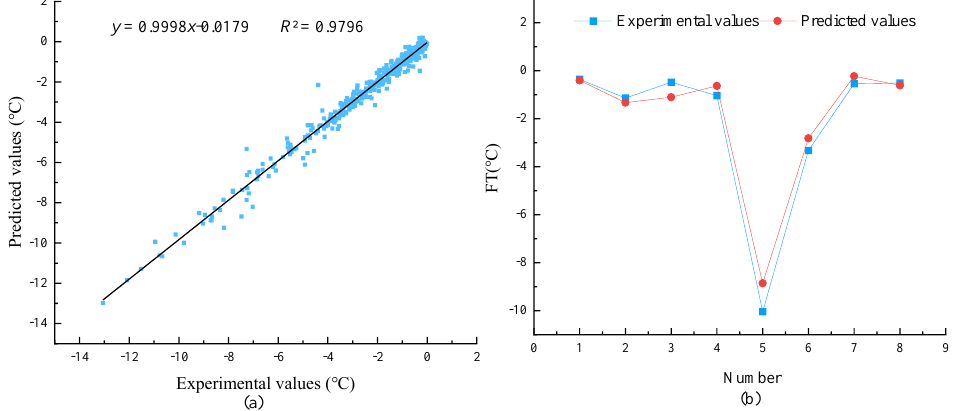
Figure 6. Comparison of predicted and experimental values for the RBFNN model: ( a ) training values; ( b ) testing values.